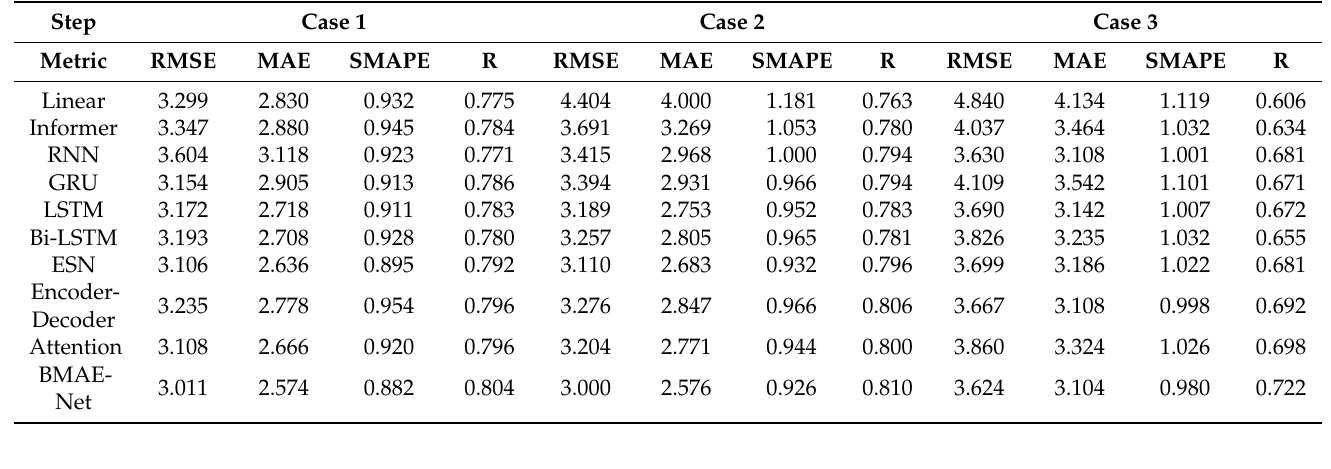
Table 4. Experimental results for temperature from the Beijing station.